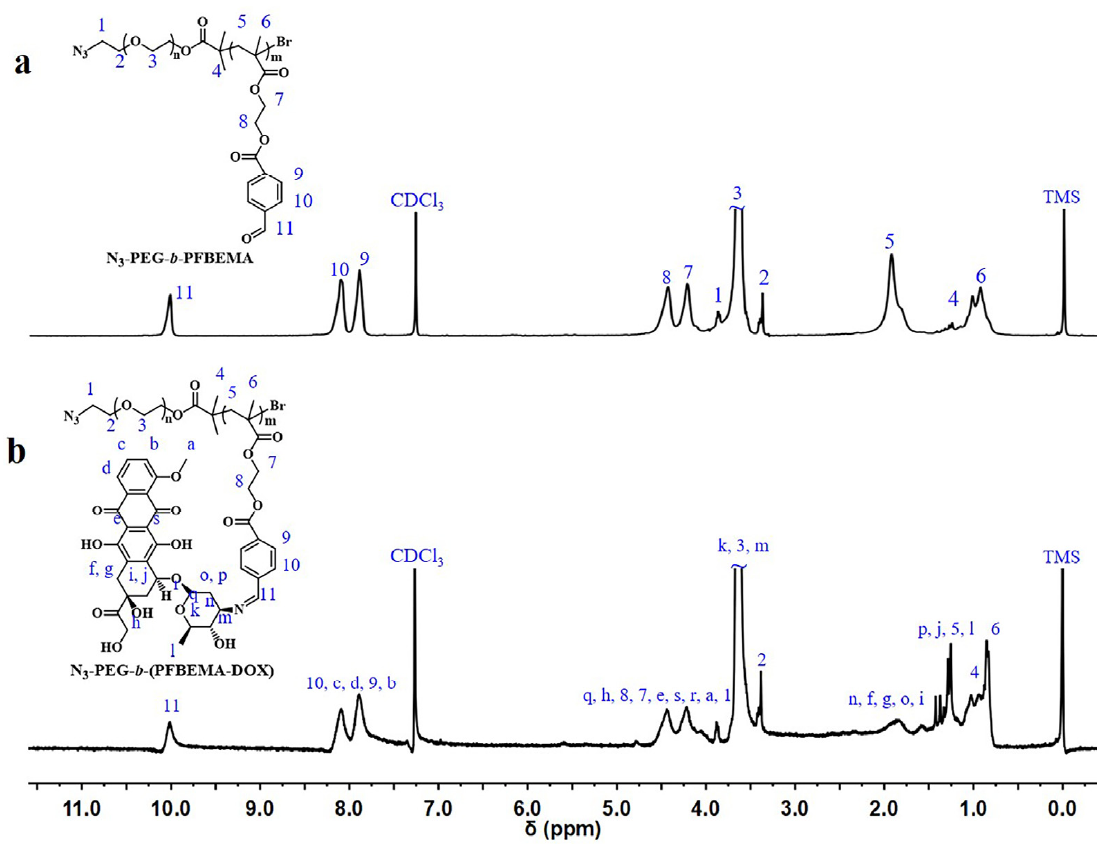
Figure 1. 1 H NMR spectra of ( a ) N 3 -PEG- b -PFBEMA and ( b ) N 3 -PEG- b -(PFBEMA-DOX) (solvent: CDCl 3 ). The chemical shift peaks in the 1 H NMR spectra are assigned to different protons, which are represented by numbers and letters, respectively.